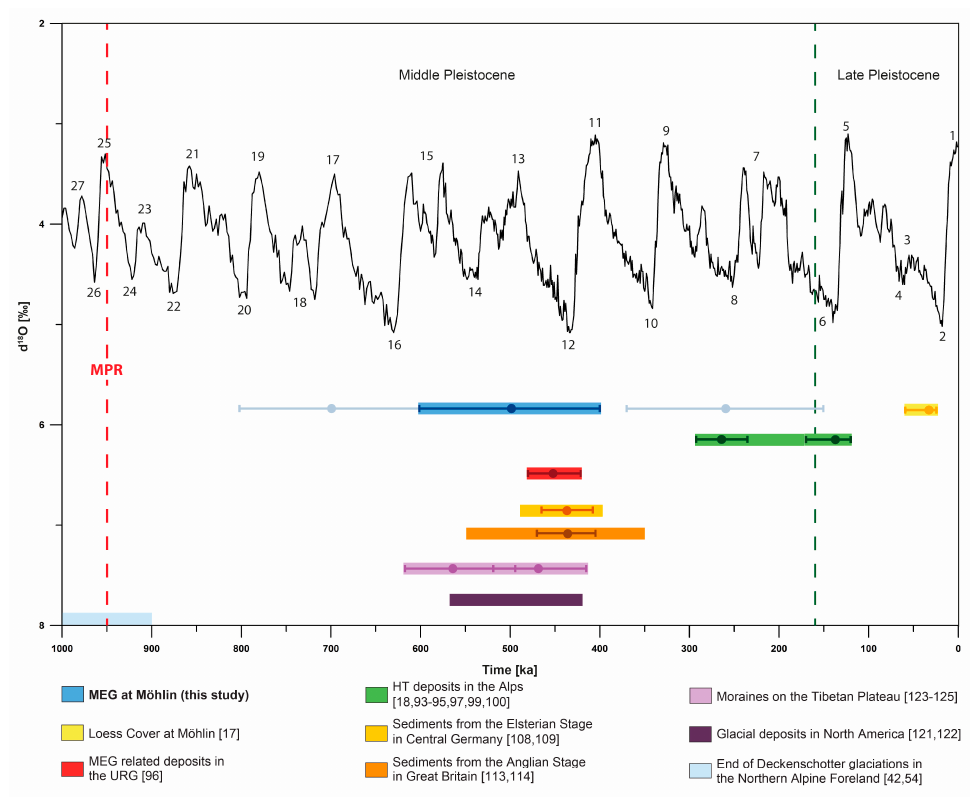
Figure 9. δ 18 O variation in the last 1 Ma (modified after [15]). The upper error ranges of the MEG, with an age of 500 ± 100 ka, overlap with those of the Elsterian stage in Northern Europe, the Anglian stage in Great Britain, moraines on the Tibetan Plateau, while its lower error ranges overlap with glaciofluvial sediments of North America. The Alpine glaciations of 250 ka and 160 ka represent separate glaciation events that do not correlate with the MEG. The light blue bar indicates the end of Deckenschotter glaciations, which took place between ca. 2.6 and 0.9 Ma [42,54]. The red dashed line indicates the Mid Pleistocene Revolution (MPR) occurring at around 0.95 Ma [105] and the green one the boundary between the Middle and Late Pleistocene [1].